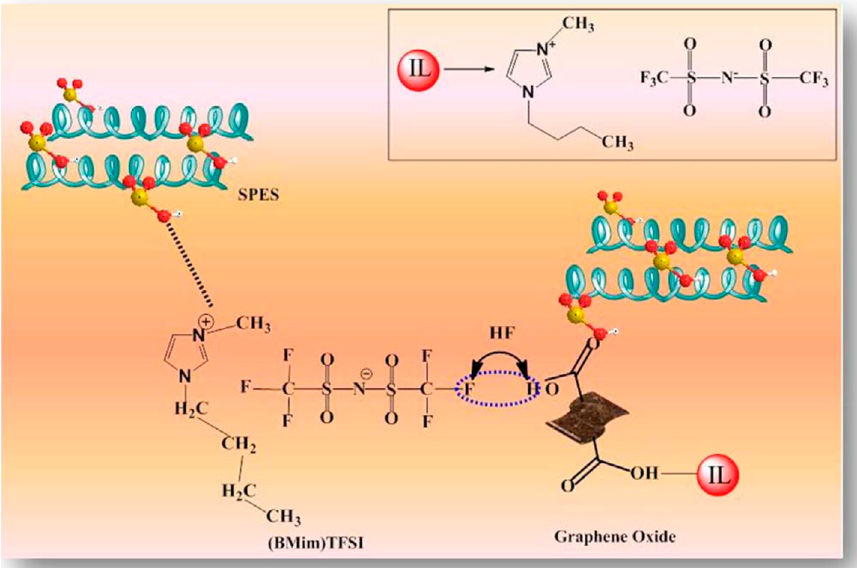
Figure 13. Schematic representation of interaction between IL-GO and SPES matrix. Reproduced from [63], with permission from Elsevier, 2018.